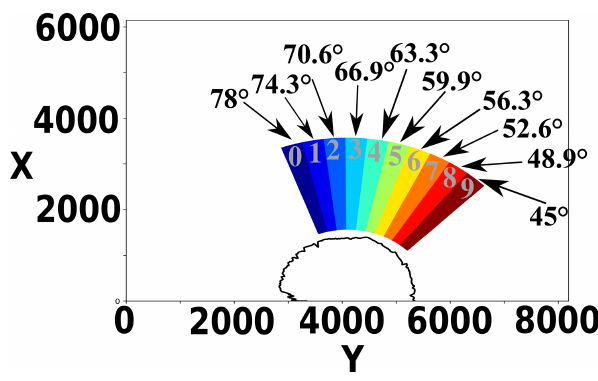
Figure 2. Initial location of the 10 sampling boxes (labeled from zero to nine) which map the upstream ion foreshock region. All ions belonging to a given box are represented by the same color for statistical analysis only (Sects. 3 and 4). The θ Bn propagation angle, where each box is initially centered at time t = 0, is reported above the corresponding identification number of the box, but these colors will not be used anymore in this